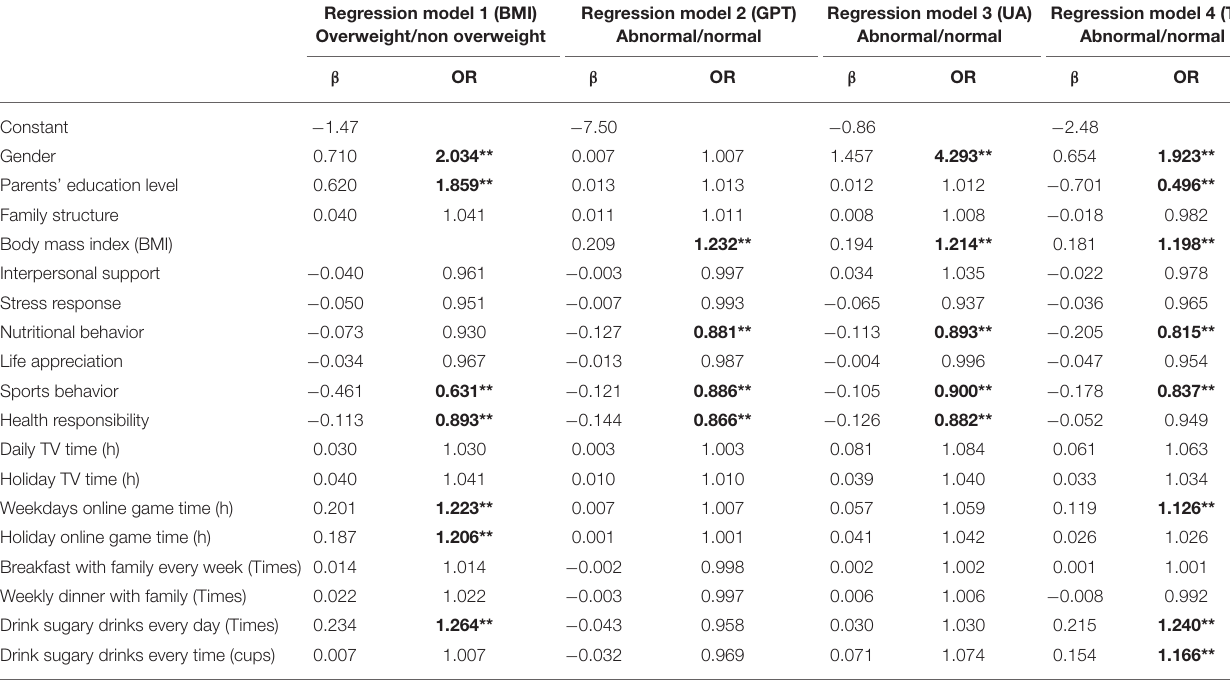
TABLE 4 | Statistical table of multiple regression model of adolescent background factors, living habits, and health promotion behavior on BMI and biochemical factors. Regression model 1 (BMI) Regression model 2 (GPT) Overweight/non overweight